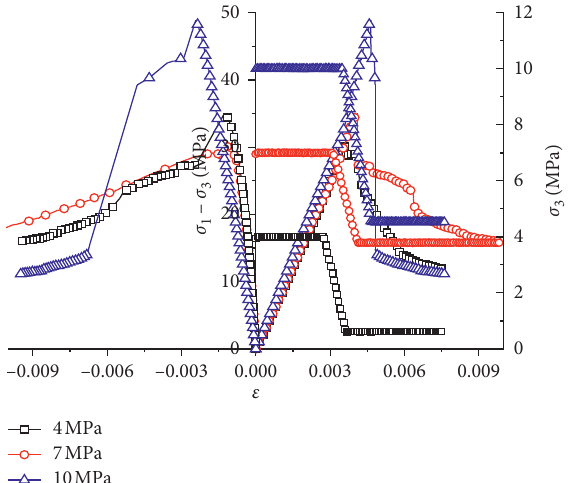
Figure 8: Stress-strain curve of coal samples under different confining pressure unloading